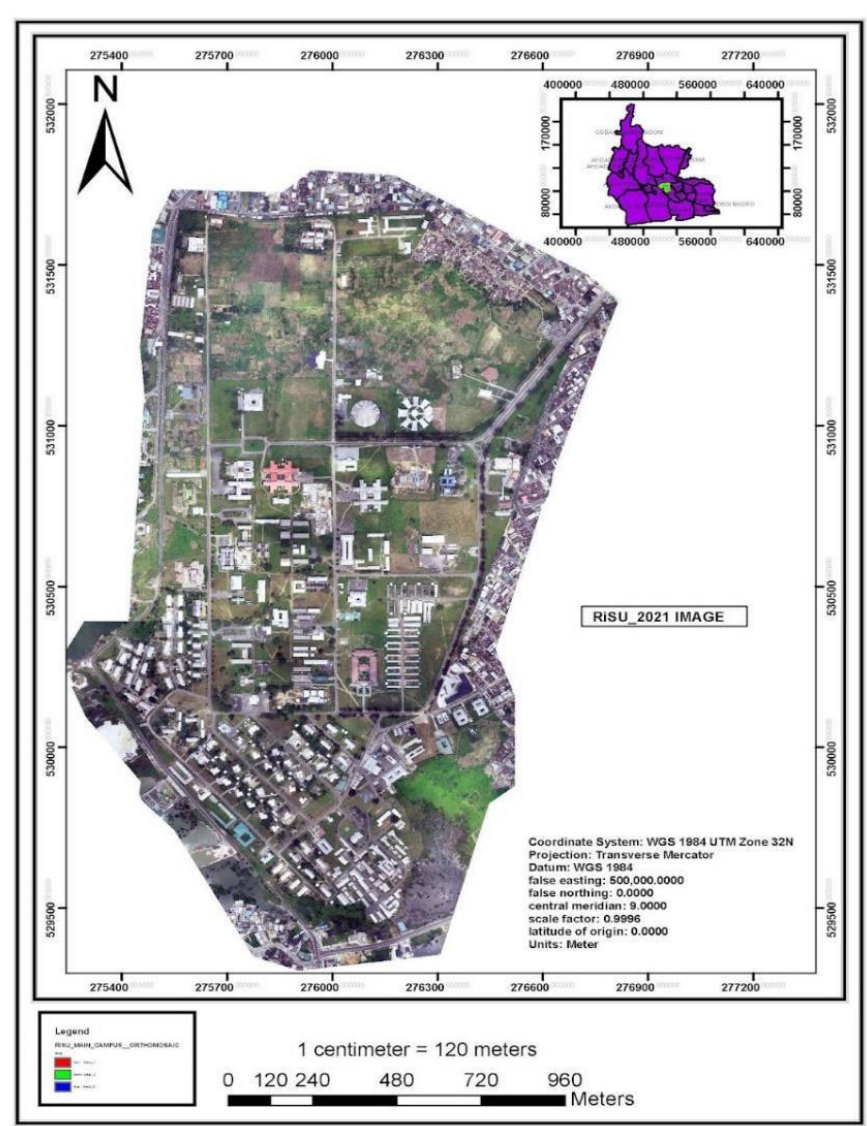
Figure 1: 2021 UAS Acquired Imagery of Rivers State University Portharcourt